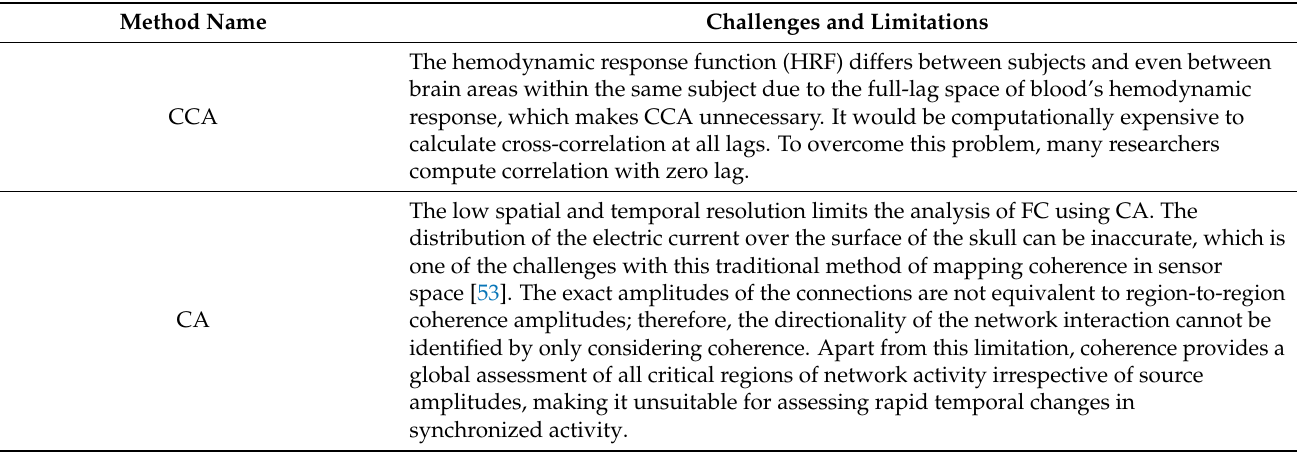
Table 3. Challenges and limitations of functional connectivity